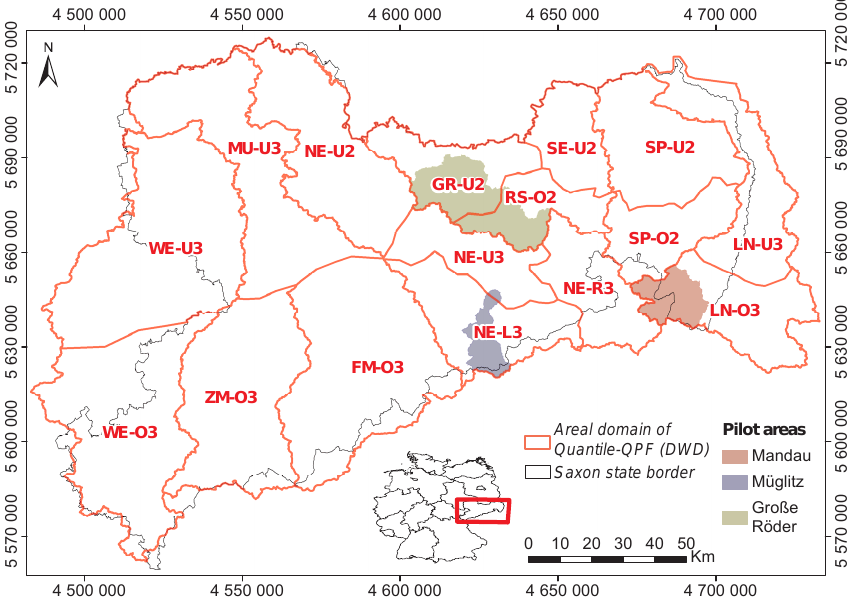
Figure 1. Overview map indicating the areal domain of the Quantile-QPF for Saxony (16 regions; e.g., “FM-O3” indicates the parts of the Freiberger Mulde catchment above 300ma.s.l.). The area of the regions ranges between approximately 600 and 2700km 2 . Furthermore, the hydrological pilot areas (cf. Sect. 2.3) are shown. Gauss conformal projection with reference at 12 ◦ E (Zone 4). The Thumbnail map is showing the location of Saxony within